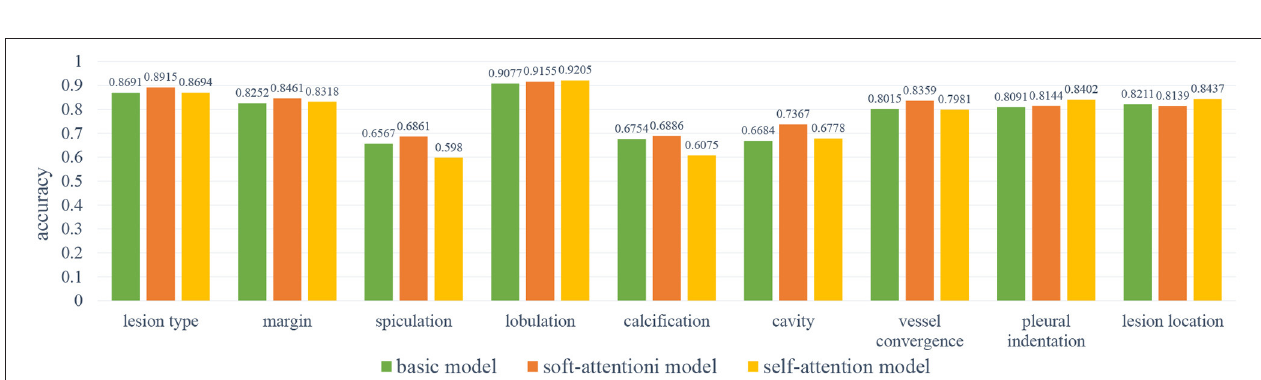
FIGURE 6 | The results of the base model and two attention models. As can be noted, the self-attention module has better results on lobulation, pleural indentation, and lesion location attributes; the soft-attention module has better results on lesion type, margin, spiculation, calcification, cavity, and vessel convergence attributes.